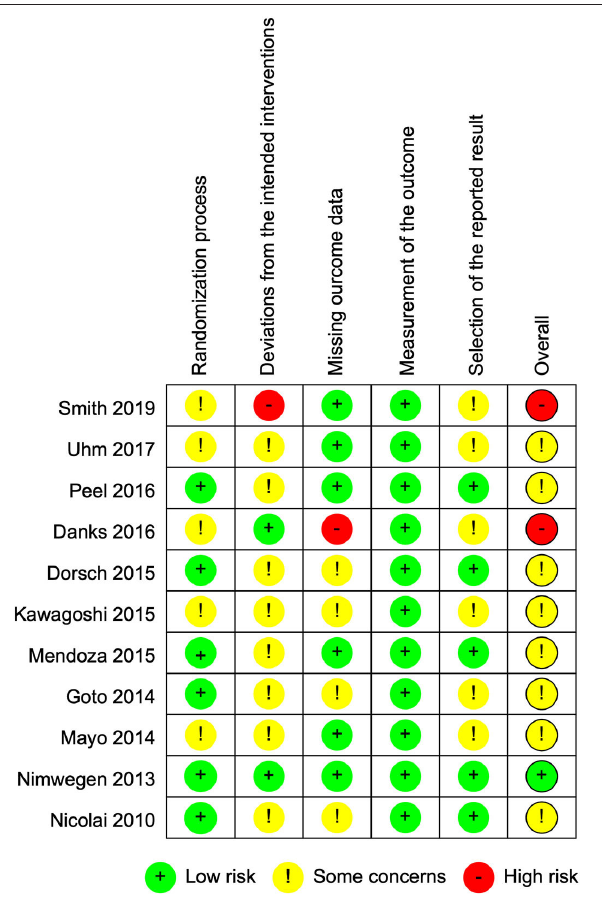
FIGURE 3 | Risk of bias summary: review authors’ judgments about each risk of bias item for each included